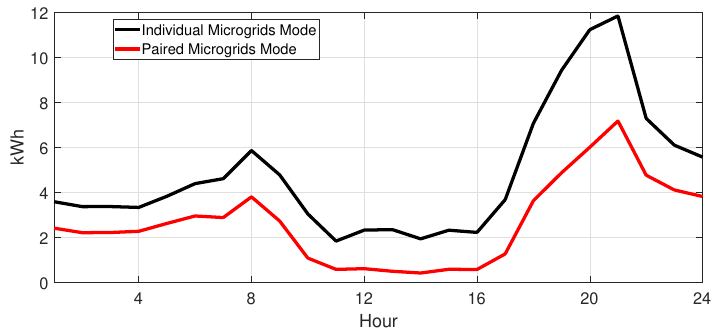
Figure 7. Average daily energy from external prosumers to both prosumers.